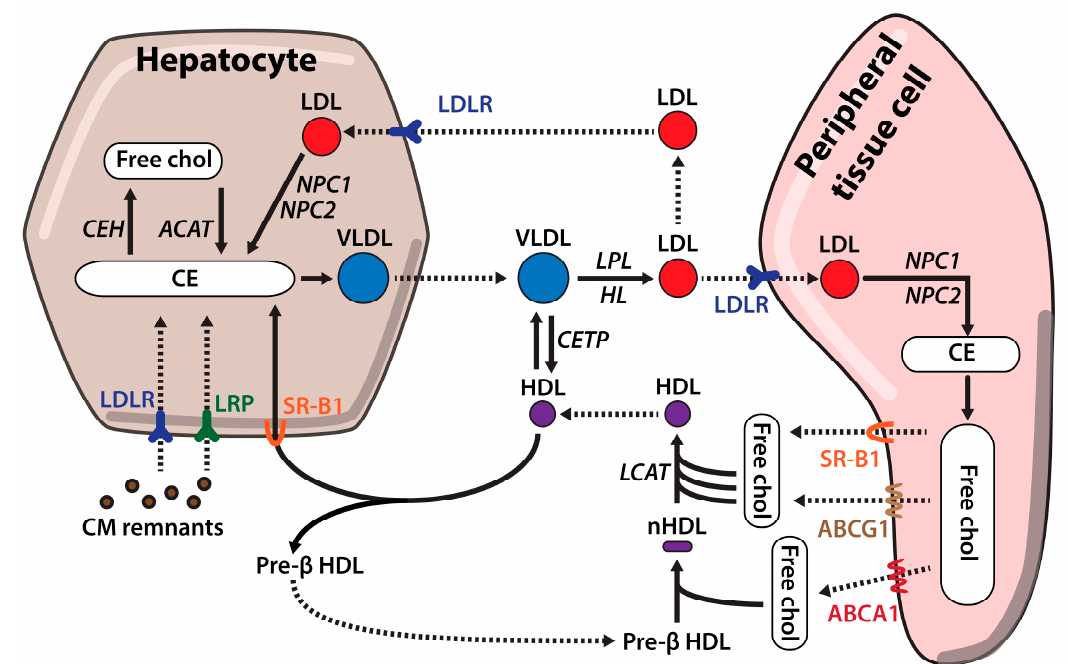
Figure 2. Cholesterol metabolism. Cholesterol is secreted from the liver to peripheral tissues in triglyceride rich lipoproteins, very low density lipoproteins. Once in the bloodstream, VLDL are transformed into cholesterol rich LDL particles by interaction with different proteins as LPL or exchange of lipids and apolipoproteins with high density lipoproteins LDL particles are taken up by peripheral tissue cells through LDLR. Excess cholesterol from peripheral tissues is packaged in HDL lipoproteins for it clearance. First, free cholesterol is transferred to lipid poor pre- β HDL through ABCA1. Second, this first cholesterol loading changes HDL conformation and allow its interaction with ATP-binding cassette subfamily G member 1 and SR-B1 transporters that along with Lecithin-cholesterol acyltransferase produce mature HDL particles that are transported back to the liver for their clearance. Abbreviations: NPC1: Niemann-Pick C1; NPC2: Niemann-Pick C2; ACAT: